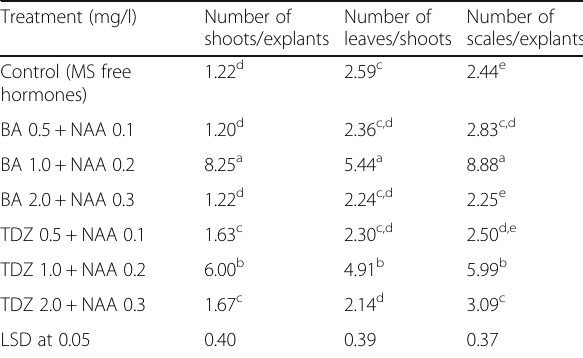
Table 2 Effect of BA and TDZ combined with NAA at different concentrations on in vitro shoot proliferation of Lilium Treatment (mg/l) Number of Number of Number of shoots/explants leaves/shoots scales/explants Control (MS free